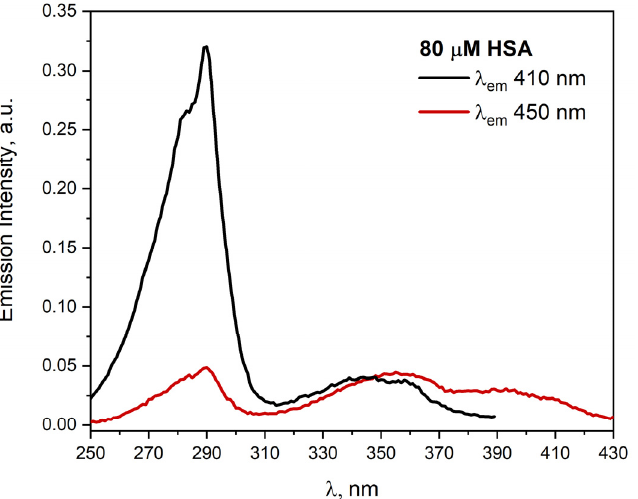
Figure 2. Emission excitation spectra of the neat HSA solution (80 µM). The emission wavelengths were 410 and 450 nm. were 410 and 450